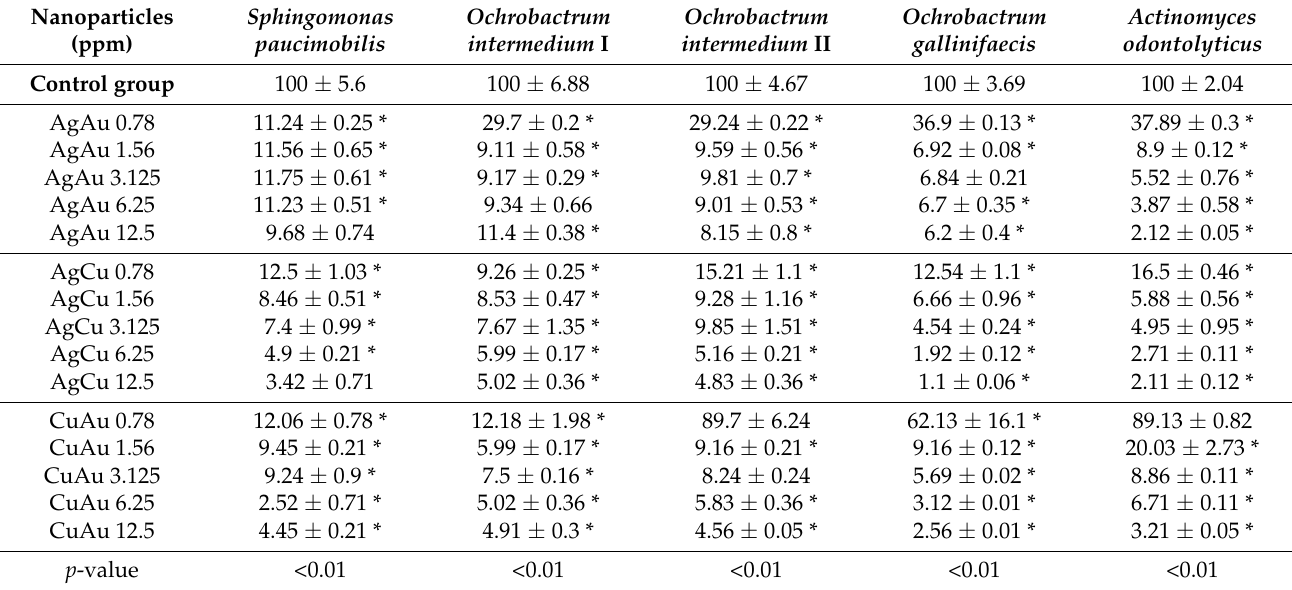
Table 6. Viability analysis of the microorganisms isolated from ulcerated hoof sores and exposed to AuNP, AgNP, and CuNP